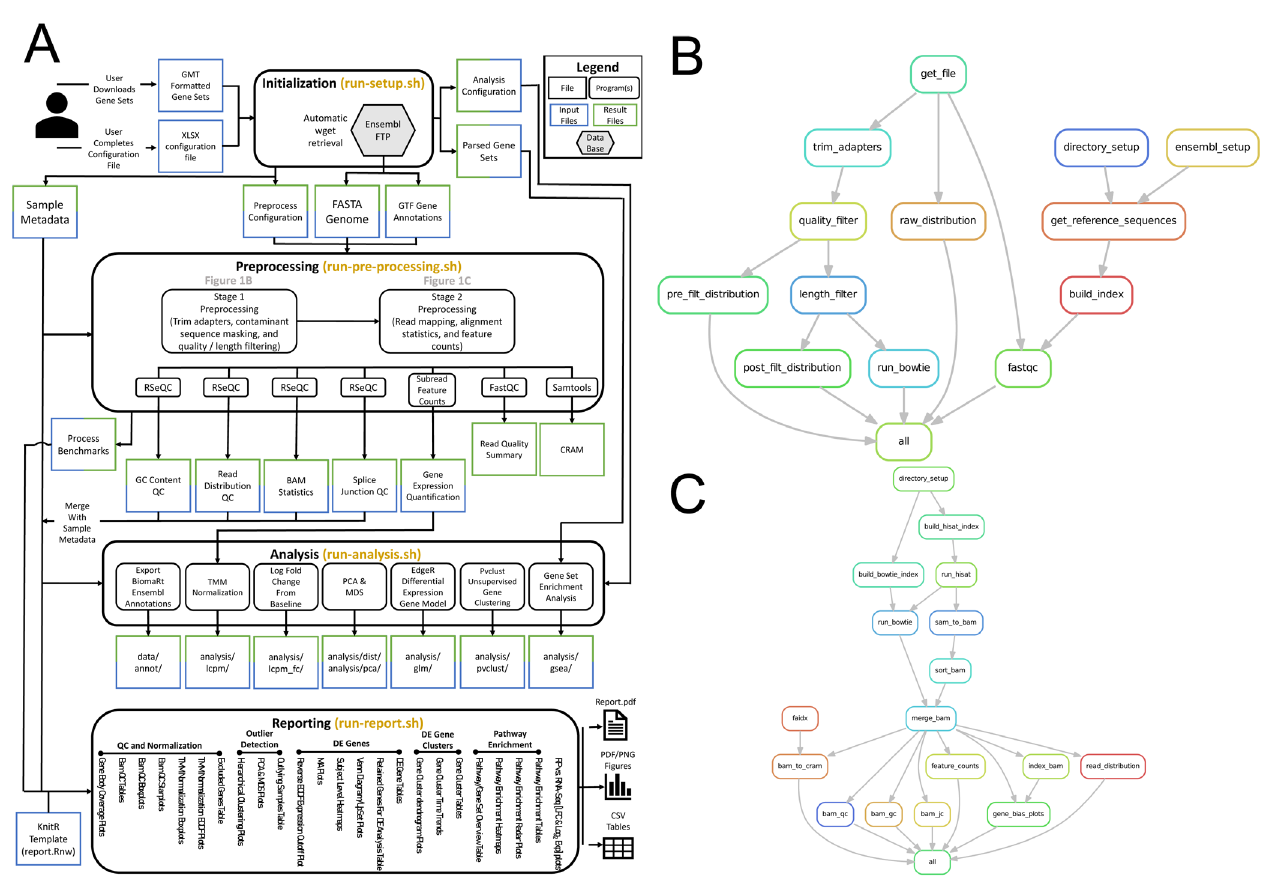
Figure 1. RPREP implementation overview. ( A ) The software is organized into four main components: (1) setup (2) pre-processing (3) analysis, and (4) reporting. Preprocessing steps are organized into two stages. ( B ) Pre-Processing Stage 1 executes read filtering steps. ( C ) Pre-Processing Stage 2 executes read mapping and gene level quantification. ( B ) and ( C ) depict the respective Snakemake workflow in the form of a directed graph indicating sequential and parallel processing of certain pre-processing